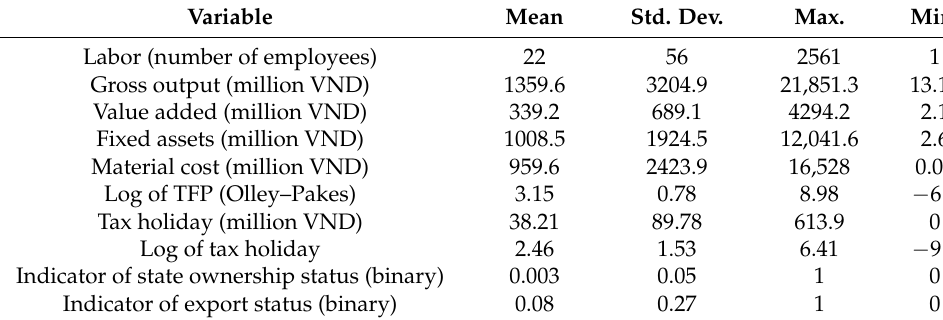
Table 3. Descriptive